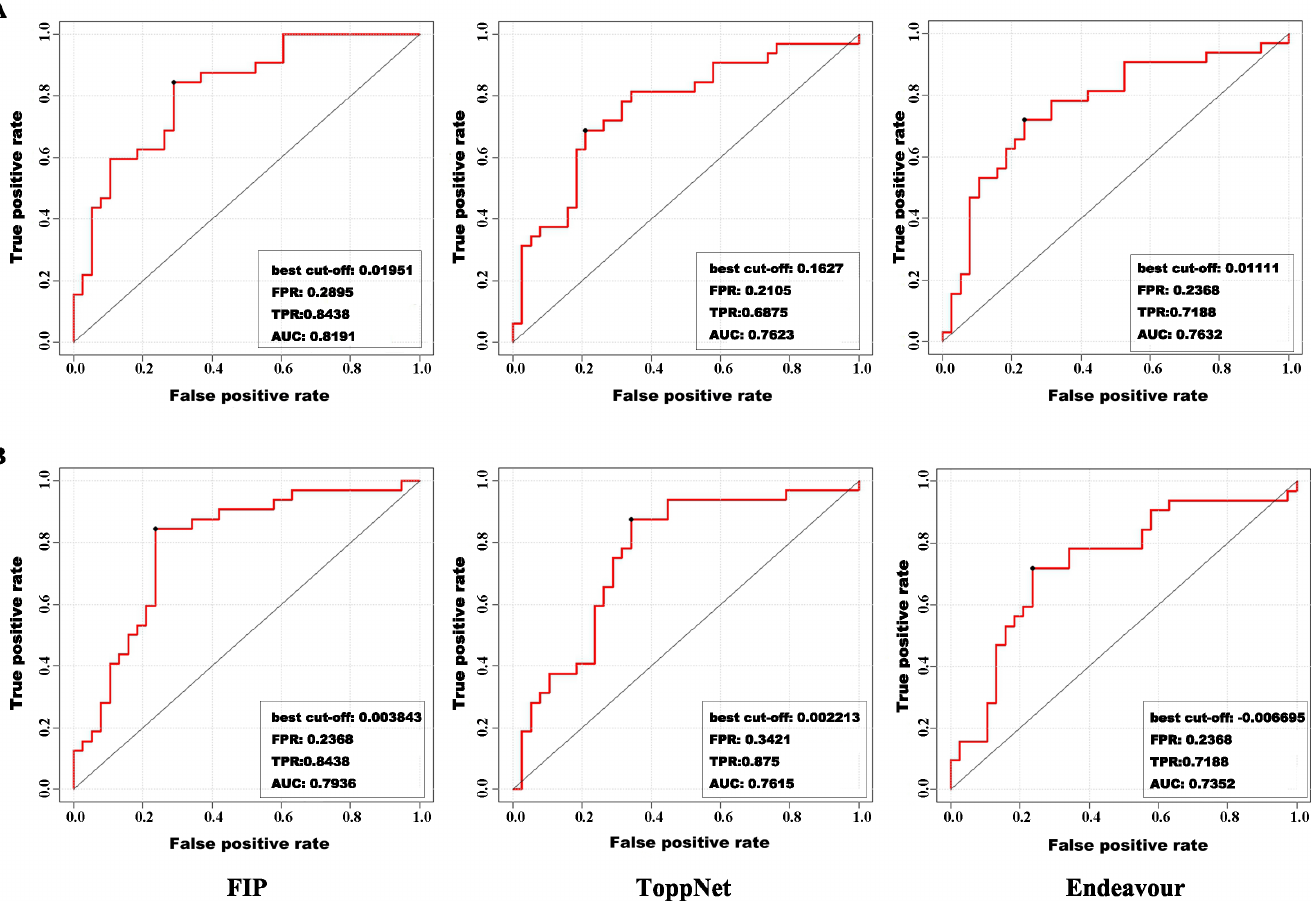
Fig 9. The performance of sample classification with top-ranked candidates of FIP, ToppNet, and Endeavour methods. (A) ROC curves of FIP, ToppNet, and Endeavour methods with the top 50 candidates as classification characteristics (B) ROC curves of FIP, ToppNet, and Endeavour methods with the top 100 candidates as classification